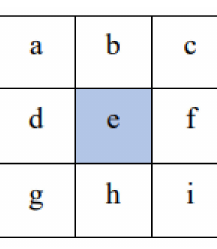
Figure 2. Diagram of the numbering of adjacent image